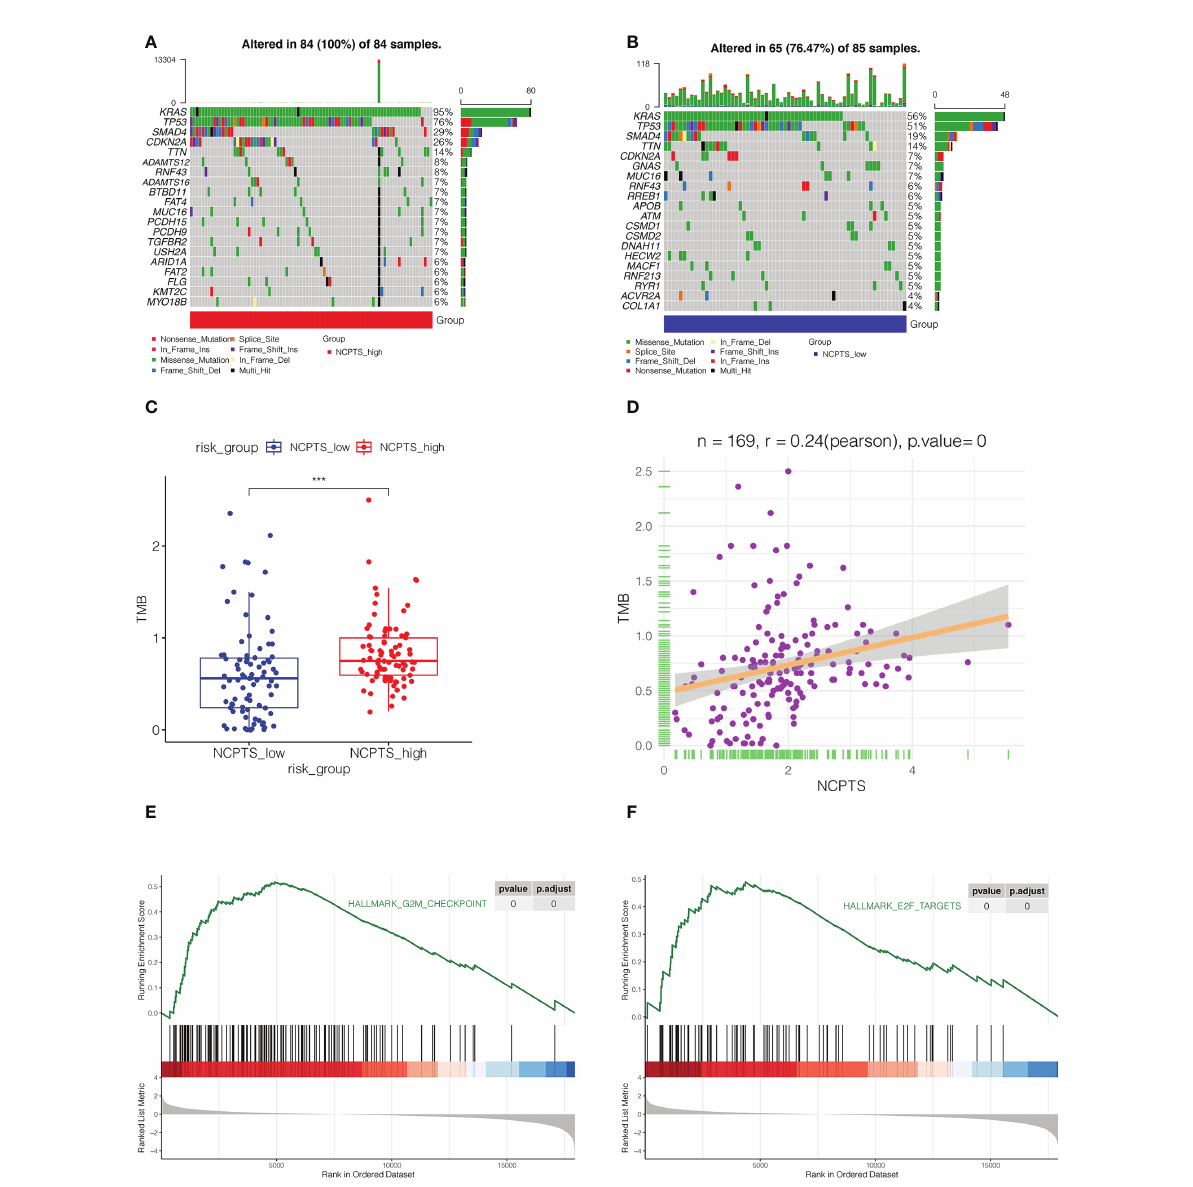
FIGURE 7 Mutation landscape analysis. (A) The mutation landscape of NCPTS_high group. (B) The mutation landscape of NCPTS_low group. (C) Analysis of tumor mutation load(TMB) between NCPTS_high and NCPTS_low groups. The TMB of the NCPTS_high group was higher. ***P<0.001 (D) Pearson correlation analysis showed a positive correlation between NCPTS and TMB. (E, F) GSEA showed that G2M CHECKPOINT and E2F TARGETS pathways related to cell cycle were activated in the NCPTS_high